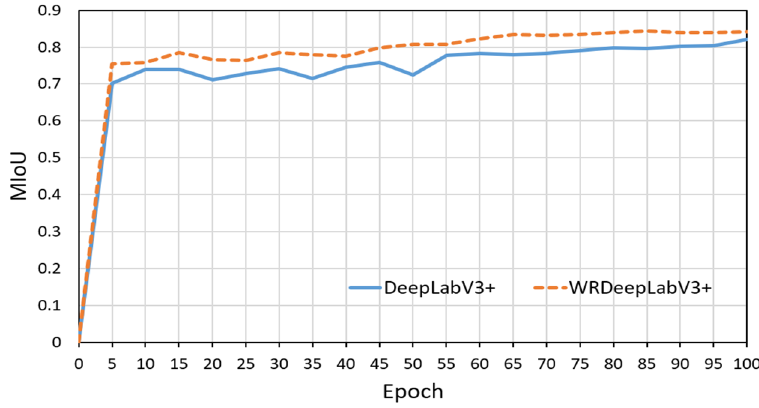
Figure 9. Comparison of DeepLabV3+ and WRDeepLabV3+ under CosLR and Adam. Secondly, we compare WRDeepLabV3+ without and with the attention mechanism .